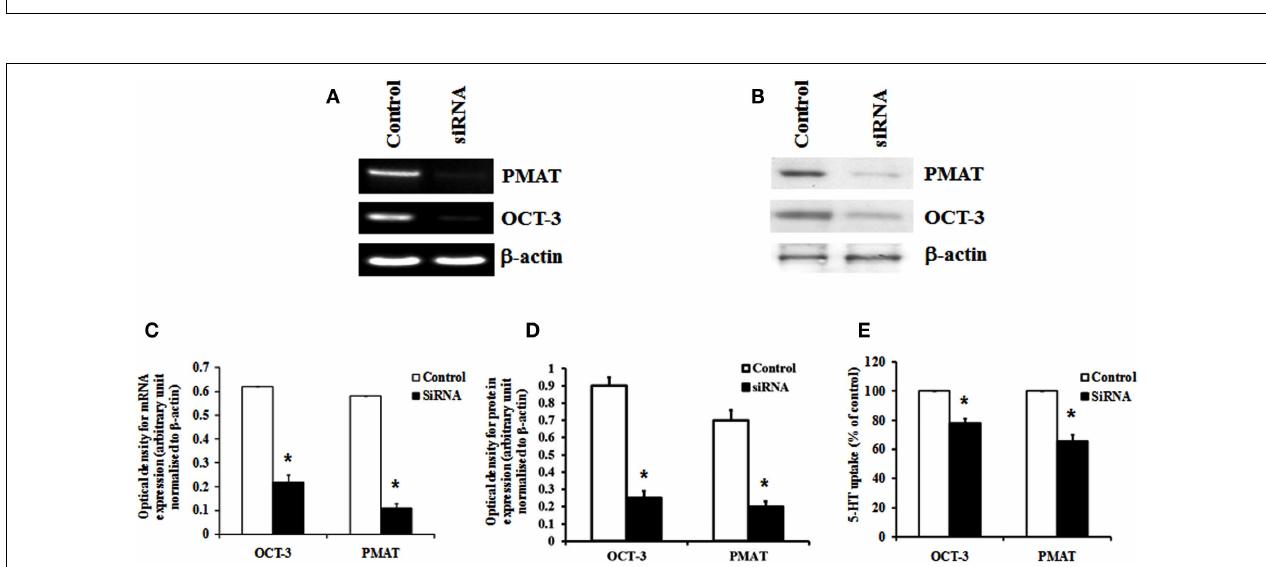
FIGURE 4 | Reverse transcription-polymerase chain reaction analyses of various 5-HT transporter mRNAs in HBVSMCs. PCR products are seen in reactions using oligonucleotide primer pairs for (A) OCT-3 and (B) PMAT but not for (A) OCT-1, OCT-2, (C) SERT, (D)